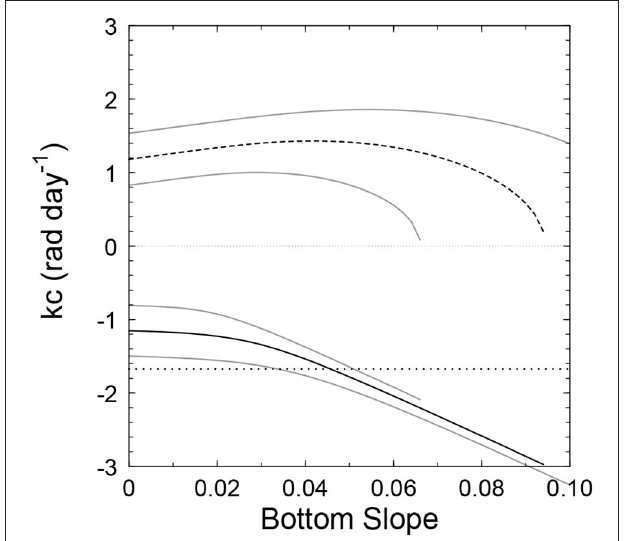
FIGURE 14 | The angular frequency, kc r , (solid line) and the growth rate, kc i , (dashed line) of the most unstable wave as a function of the bottom slope, α . The dotted horizontal line indicates the angular frequency of the peak of the power spectrum at mooring M3. The gray lines indicate kc r and kc i obtained when U 3 was changed by ± 30%. The gray line for kc r is not drawn when the unstable wave is